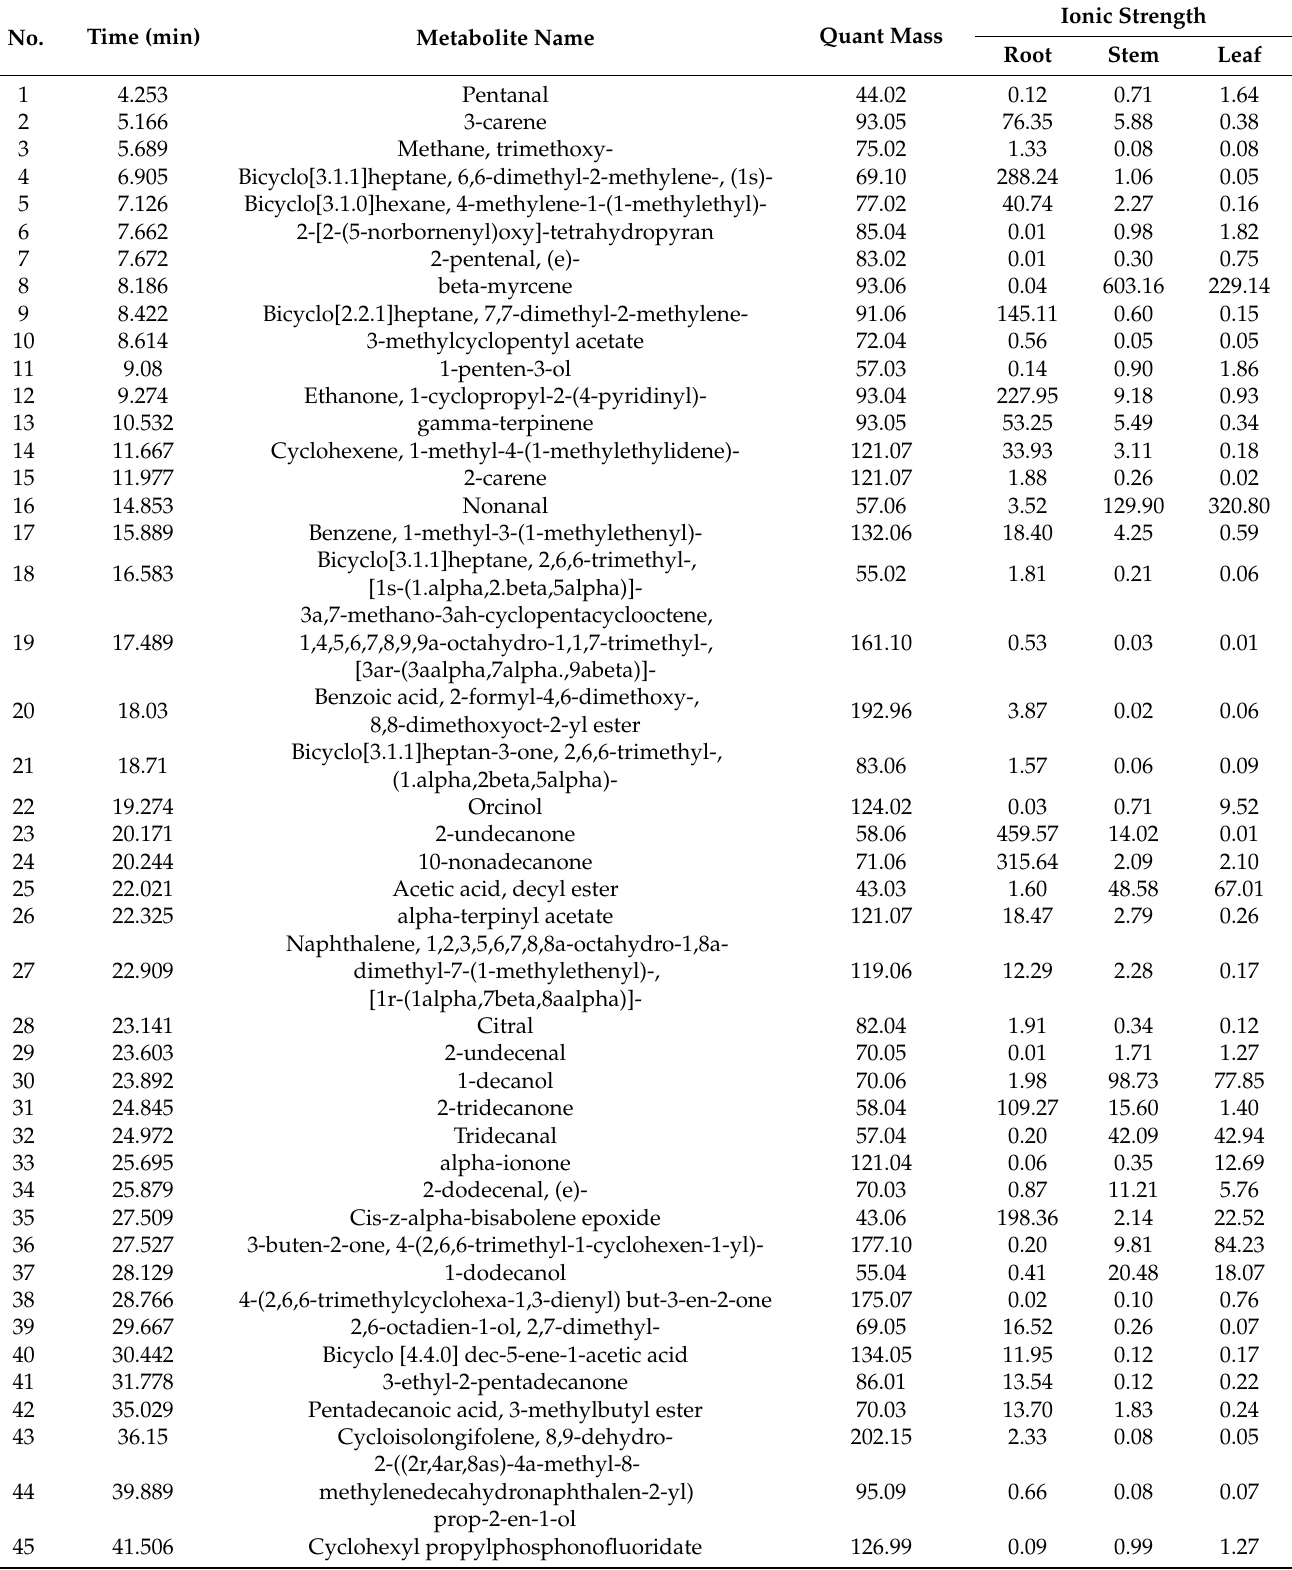
Table 2. Identification results of differential metabolites from different parts of Houttuynia cordata